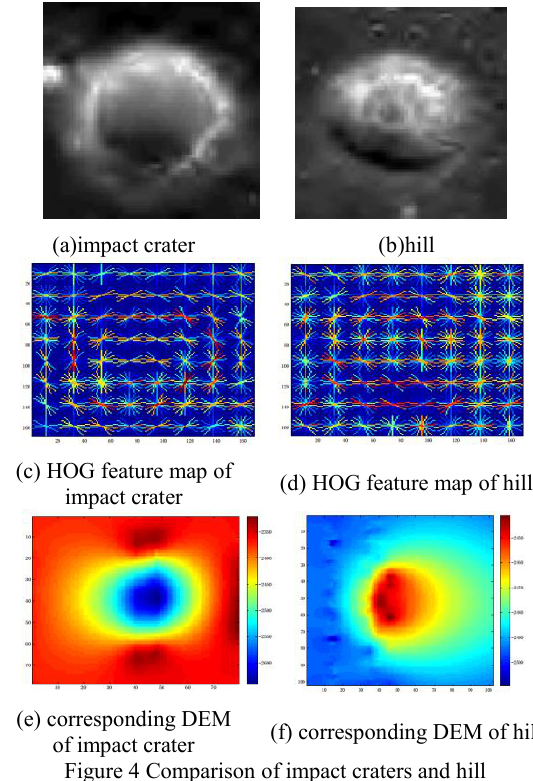
Figure 4 Comparison of impact craters and hill